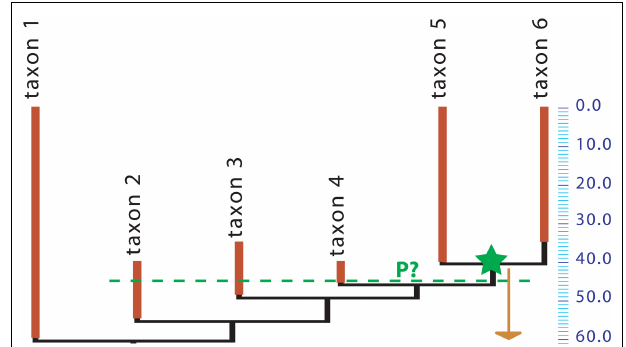
FIGURE 1 | Phylogeny of a hypothetical taxon. A crown group (containing taxa 5 and 6) appears in the fossil record 40 Ma ago (green star) but the inferred molecular age is 60 Ma (arrow).The green dashed line at 45 Ma ago shows that three stem-taxa are observed at that time. All taxa shown here may represent a single evolutionary lineage (species, under some species concepts) or clades that may include several species.What is the probability (P?) that the crown group existed 45 Ma